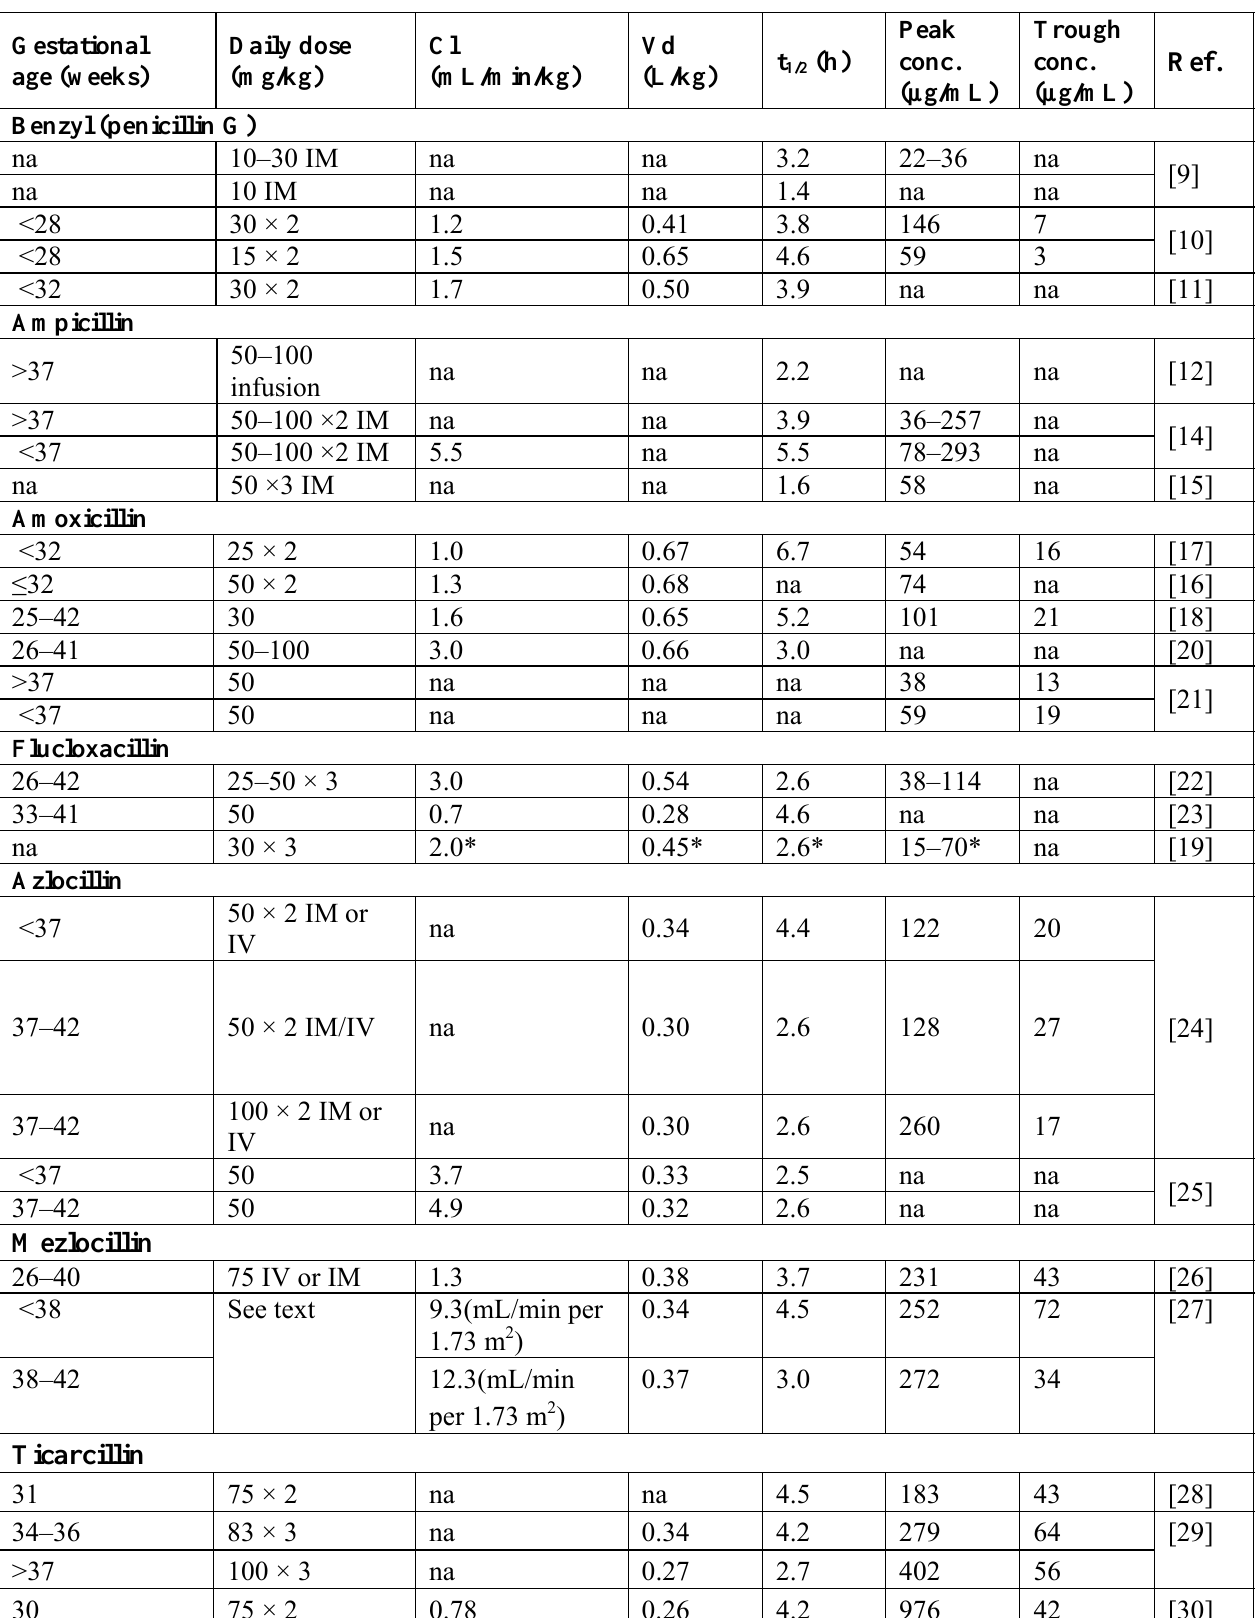
Table 2. Pharmacokinetic parameters of benzylpenicillin. Figures are the mean or range.